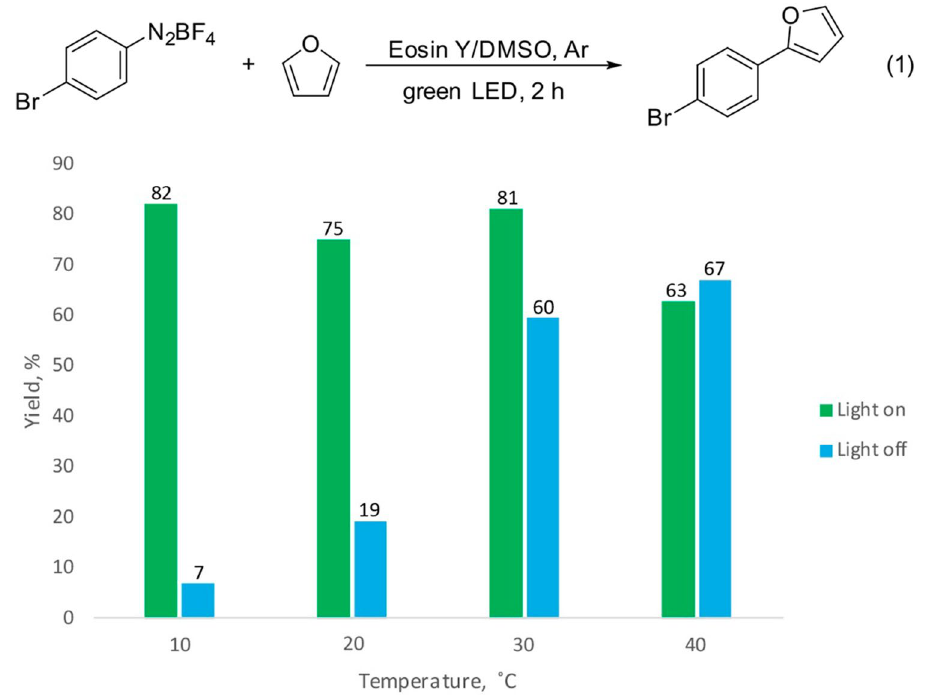
Figure 3. Model Eosin Y mediated arylation of furan. Yields were determined by 1 H